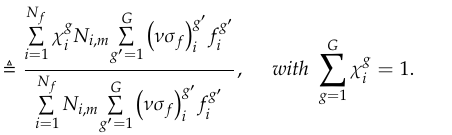
Table 5. First-Order Relative Sensitivities S ( 1 ) g Relative Sensitivities